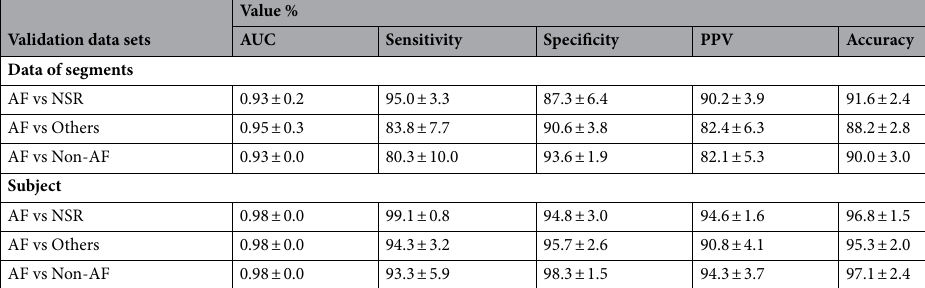
Table 1. Confusion matrix for classification of atrial fibrillation based on data of 30-s segments (n = 7320) and on voting results of whole recording on each subject (n = 453). AF atrial fibrillation, AUC area under the curve, ECG electrocardiograph, NSR normal sinus rhythm, PPV positive predictive value, rPPG remote